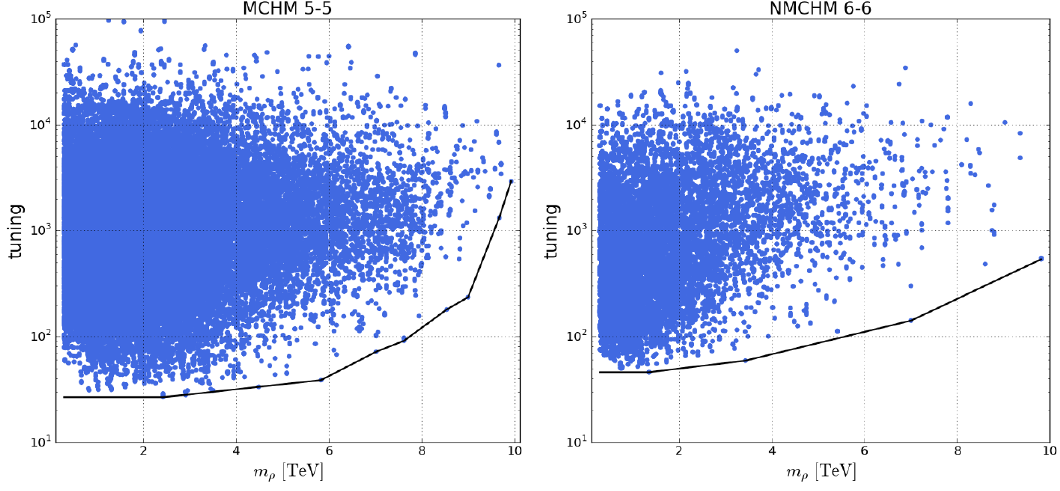
Figure 9. Comparison of the lightest vector resonance mass vs higher-order tuning, between